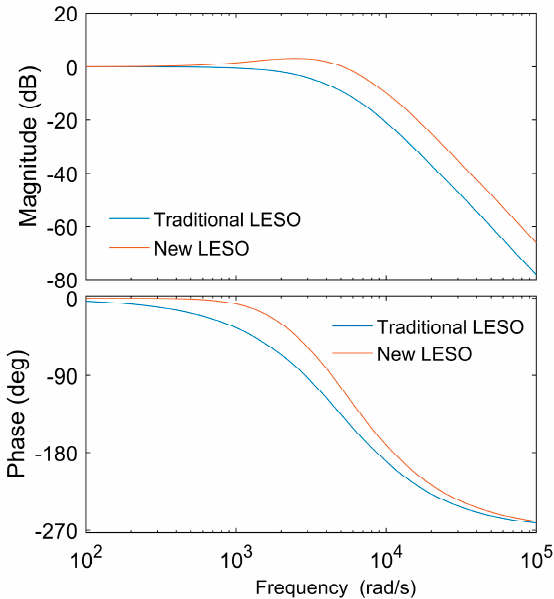
Figure 7. Amplitude and phase curve of the new LESO and the traditional LESO disturbance transfer function.